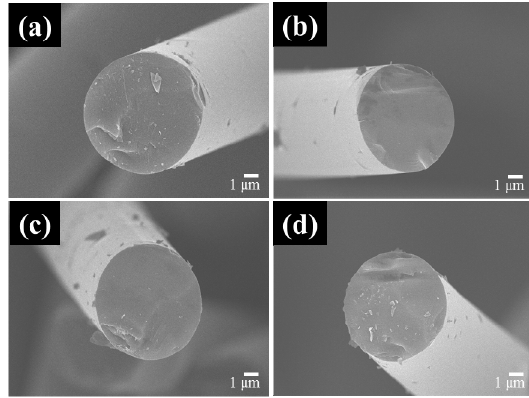
Fig. 5 Micro-morphology (cross-sectional images) of SiC fiber at different heating rates: (a) 10 ℃ /min, (b) 20 ℃ /min, (c) 30 ℃ /min, and (d) 40 ℃